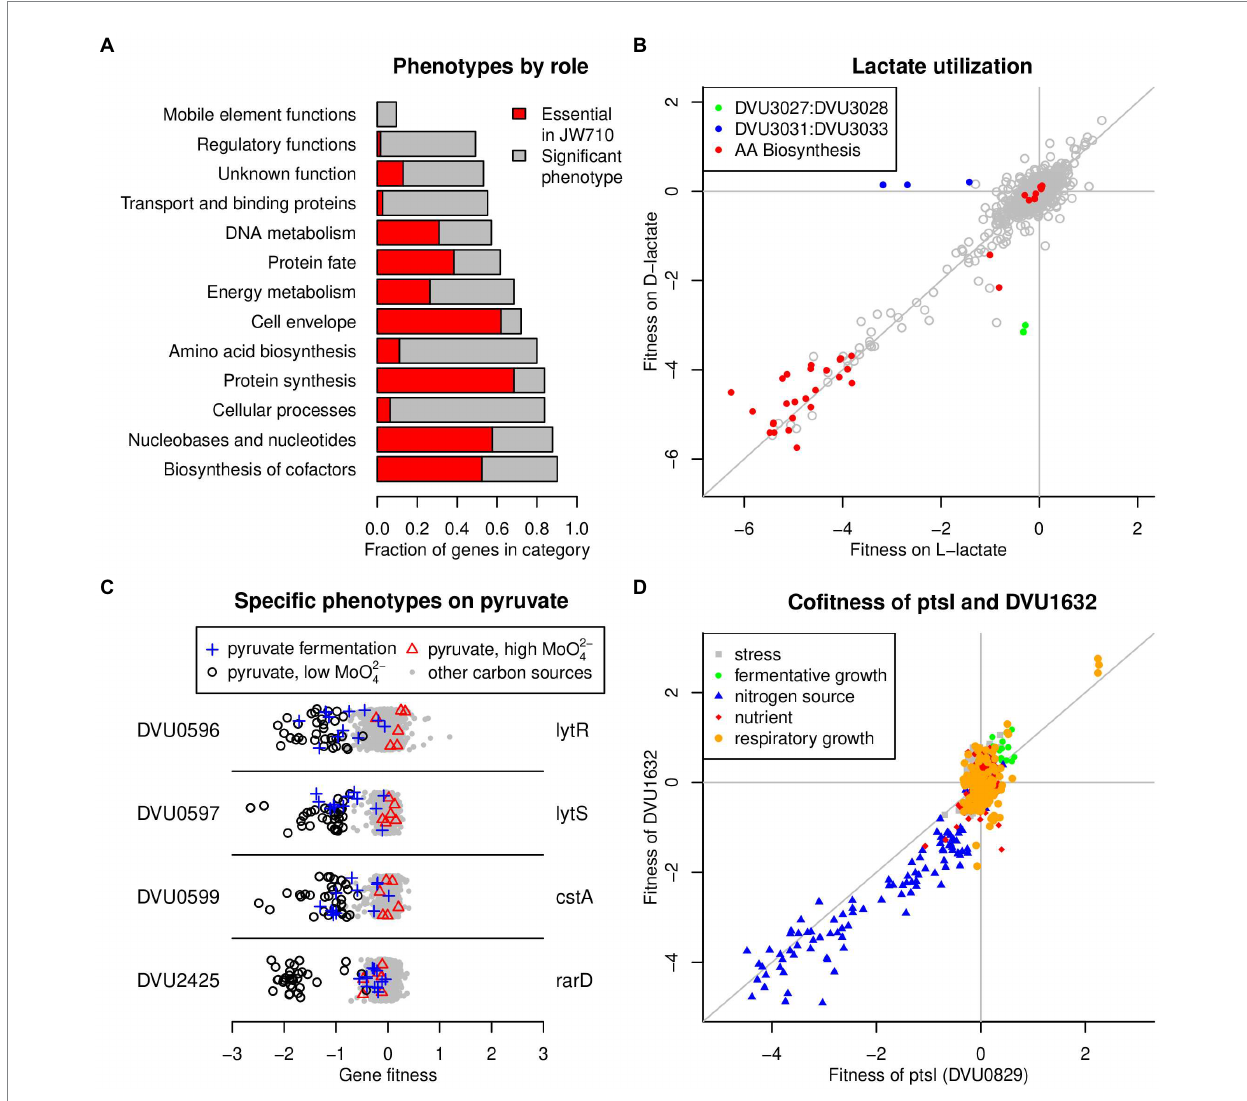
FIGURE 1 Summary of D. vulgaris Hildenborough mutant fitness dataset. (A) Fraction of genes from different functional categories that were essential (in both wild- type and JW710 backgrounds) or had a significant phenotype in at least one experiment. The functional categories are from TIGRFAMs roles (Haft et al., 2013). Only categories with 20 or more genes are shown. (B) Comparison of gene fitness values for growth in minimal media with either L-lactate ( x -axis) or D-lactate ( y -axis) as the carbon source. The data is the average of three biological replicates for each condition. “AA biosynthesis genes” are genes with TIGRFAMs role of “Amino acid biosynthesis.” (C) Specific phenotypes for genes important for growth on pyruvate. In these plots, each point represents the fitness of that gene in one of 757 genome-wide assays. Certain experiment classes are highlighted. The y -axis is random. (D) Comparison of fitness values for DVU0829 ( x -axis) and DVU1632 ( y -axis) across all 757 experiments. In panels B and D, lines show x = 0, y = 0, and x = y